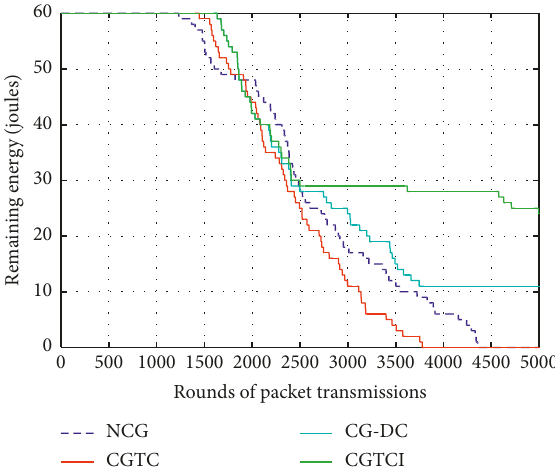
Figure 11: Energy trend for the devices located closest to the